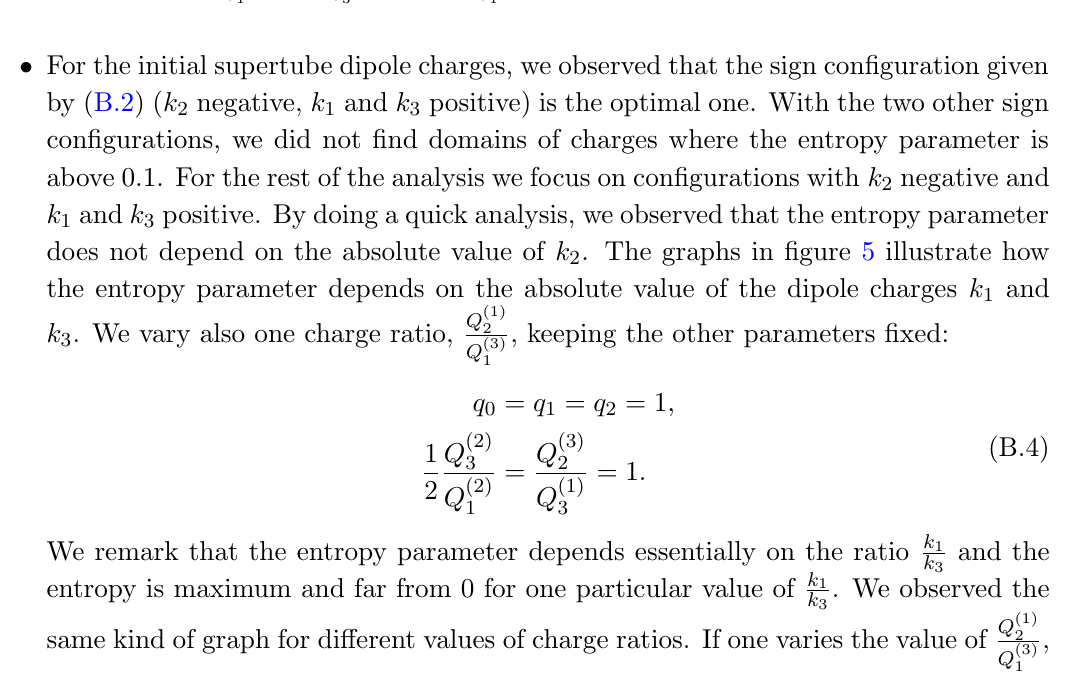
(2) (3) (1) = 2, Q = 1 and Q = 0 : 3 2 2 Q (2) 1 Q (1) 3 Q (3) 1